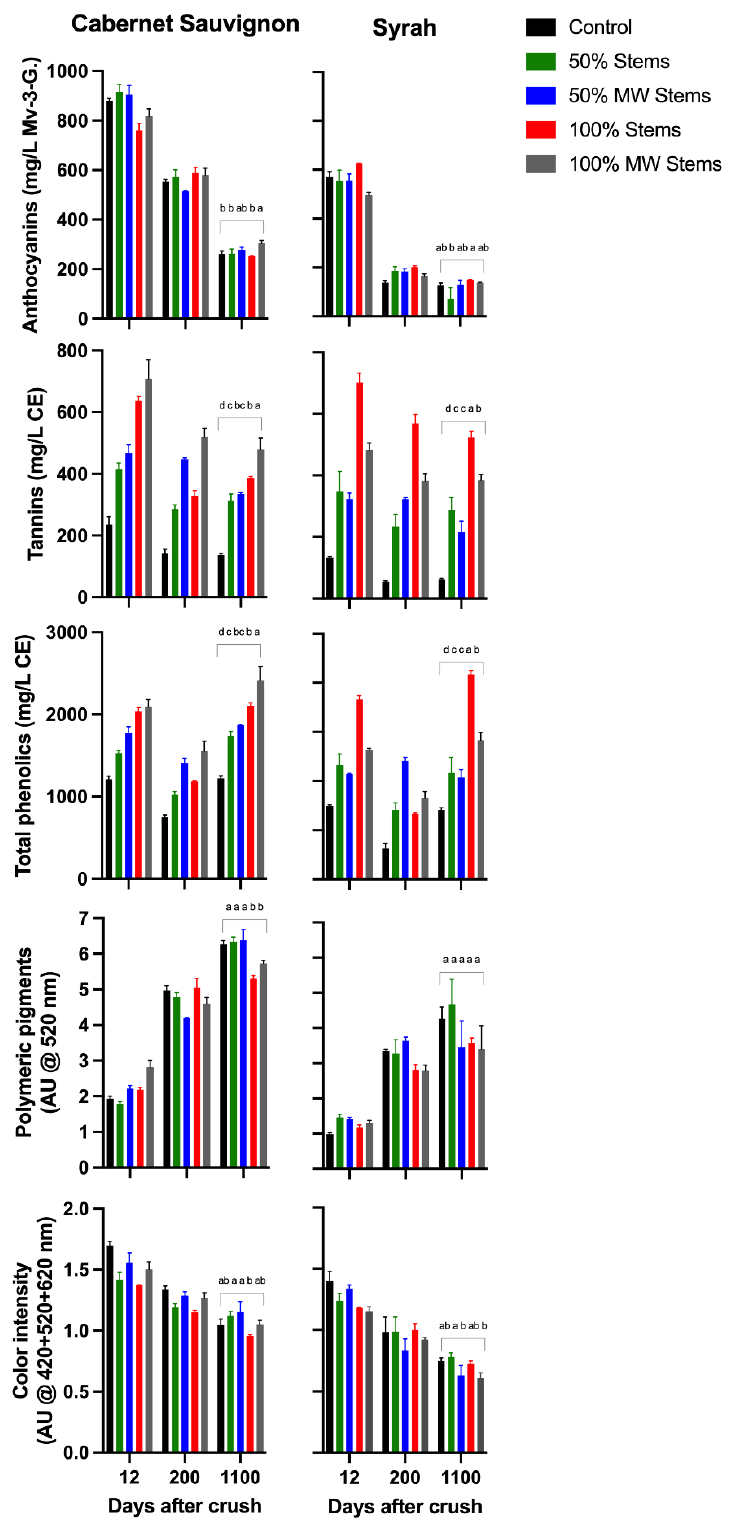
Figure 7. Evolution during winemaking and extended bottle aging of selected phenolic classes and wine color in the wines of the 2018vintage. Different letters in the last sampling point (12 months of bottle aging), indicate significant differences for Fisher’s LSD test and p < 0.05. Mv-3-G.: malvidin-3-glucoside equivalents; AU: absorbance units; CE: catechin-equivalents.